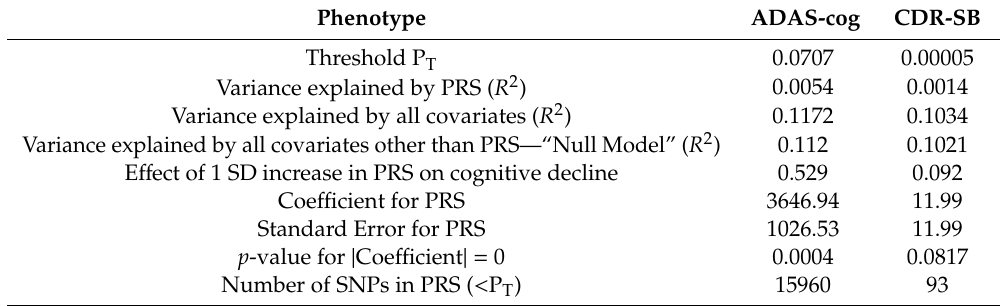
Table 2. Predictive ability of PRS on cognitive decline: The p -value threshold, P T , is the optimum p -value threshold for selecting SNPs and weights from Lambert et al. [8] to produce the most predictive PRS.